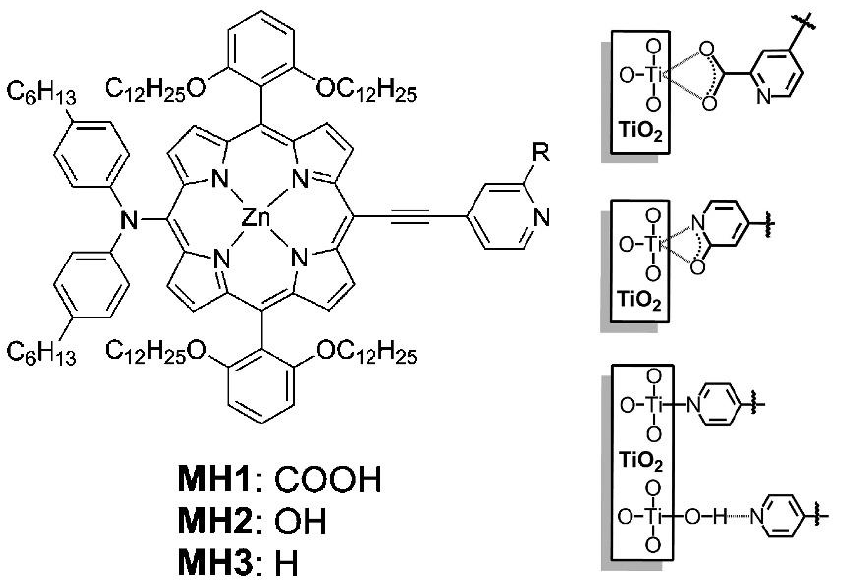
Figure 13. Molecular structures of Zn porphyrins designed by Mai et al. and binding modes of 2-carboxypyridine, 2-pyridone and pyridine anchoring groups on the TiO 2 surface. Adapted from reference [68] with permission from the American Chemical Society, copyright 2015.